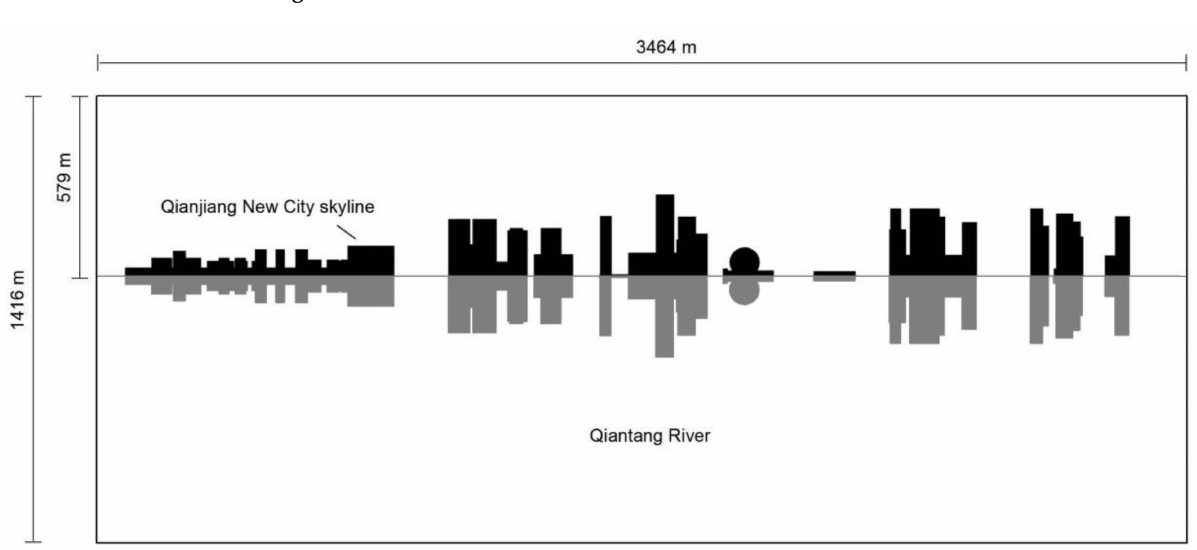
Figure 14. The field of view for vertical view.